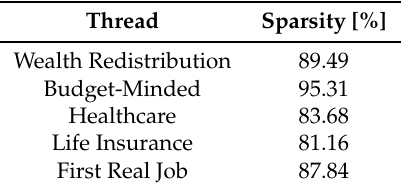
Table 4. Sparsity in weighted adjacency matrices.